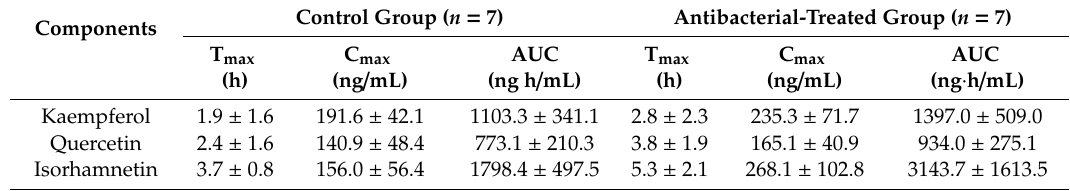
Table 3. Pharmacokinetic parameters of flavonols after oral administration of ginkgo leaf extract in control and ciprofloxacin-treated mice.